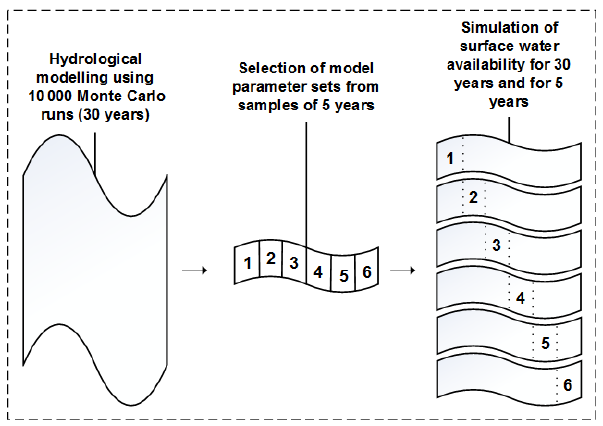
Figure 4. Obtaining hydrological model simulations from the six samples of 5 years of observed river